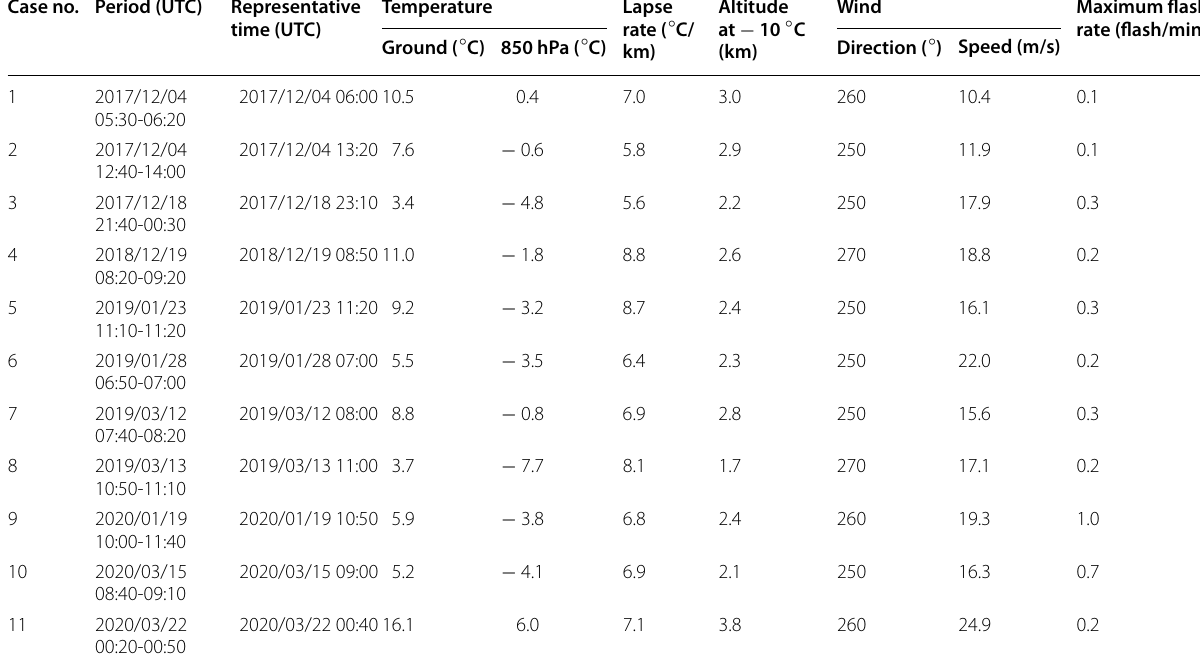
Table 3 List of non-detection cases in Kanazawa area Case no. Period